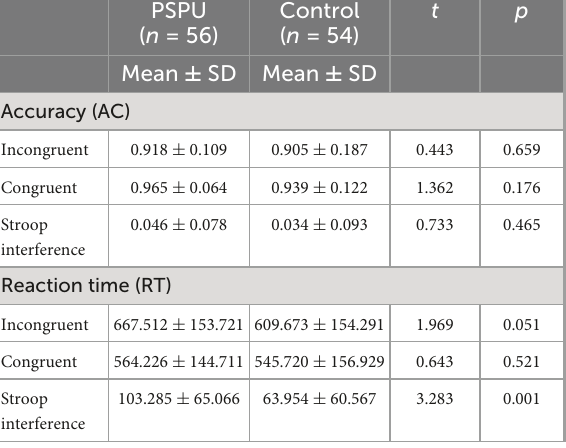
TABLE 1 Participant demographics and psychometric scores for individuals with problematic smartphone use (PSPU) and control